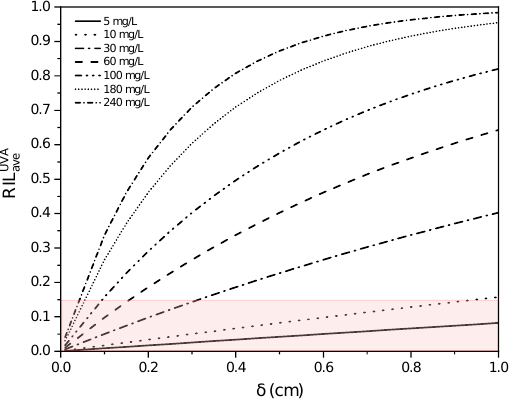
Figure 8. UVA-average RIL in terms of δ and RR239